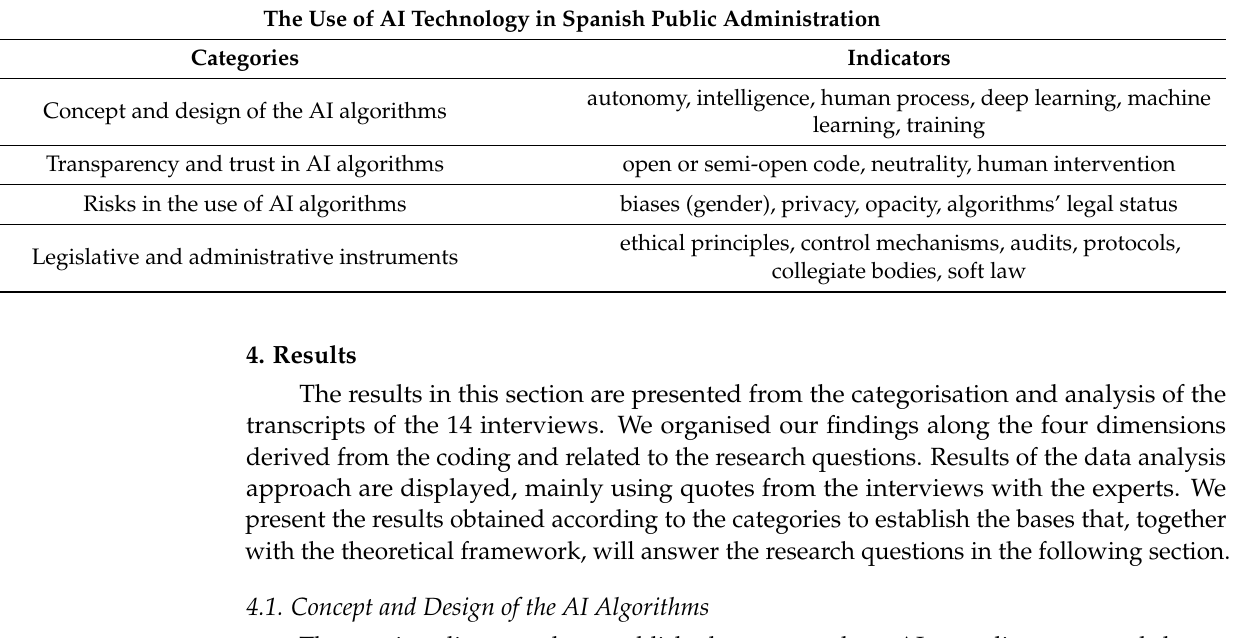
Table 3. Summary of the categories and indicators of AI in public